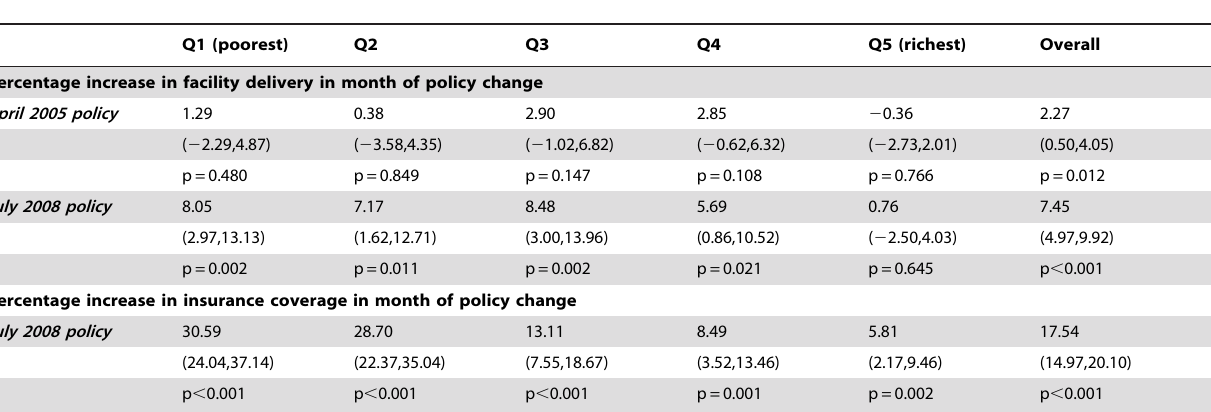
Table 2. Immediate effect of April 2005 free delivery care and July 2008 free NHIS policies on facility delivery { and insurance coverage, by wealth